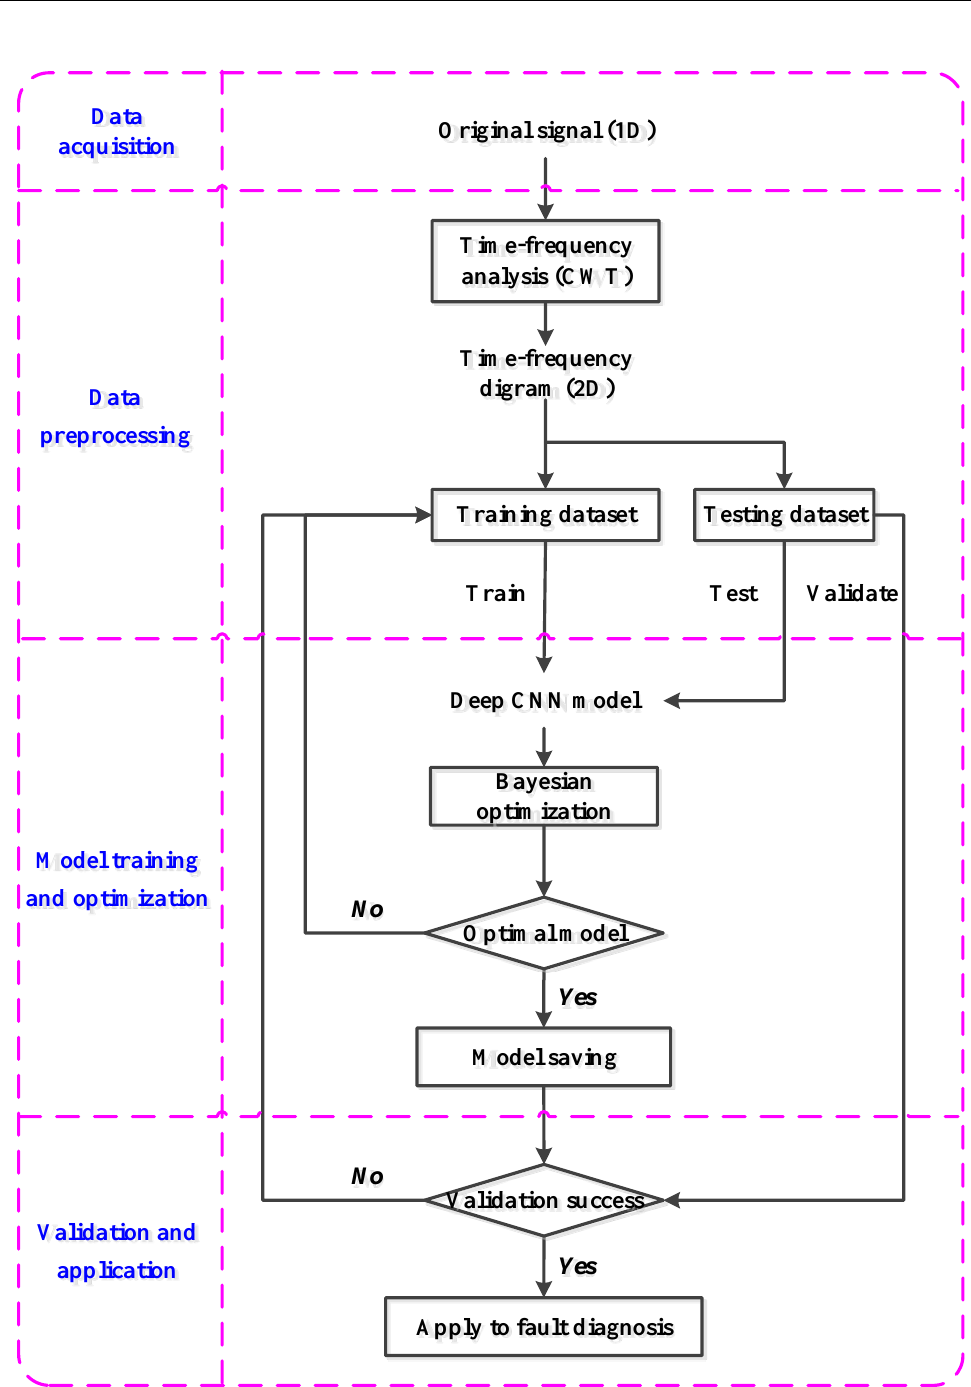
Figure 7. Flowchart of the proposed method.